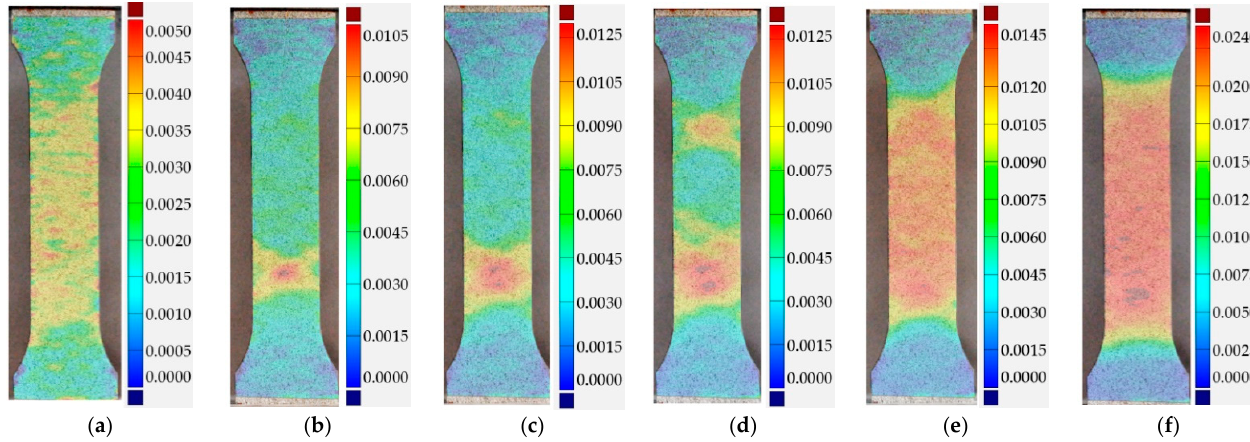
Figure 7. Distribution of strain on the surface for sample 1 for strain: ( a ) ε TOT = 0.85%; ( b ) ε TOT = 1.12%; ( c ) ε TOT = 1.27%; ( d ) ε TOT = 1.40%; ( e ) ε TOT = 1.97%; ( f ) ε TOT = 3.39%.